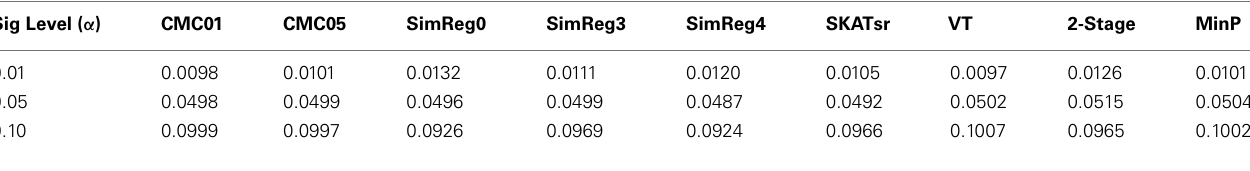
Table 2 |Type I error rates averaged over the 495 possible scenarios for 4 causal markers out of 12 and 500 replicate data sets. Sig Level ( α